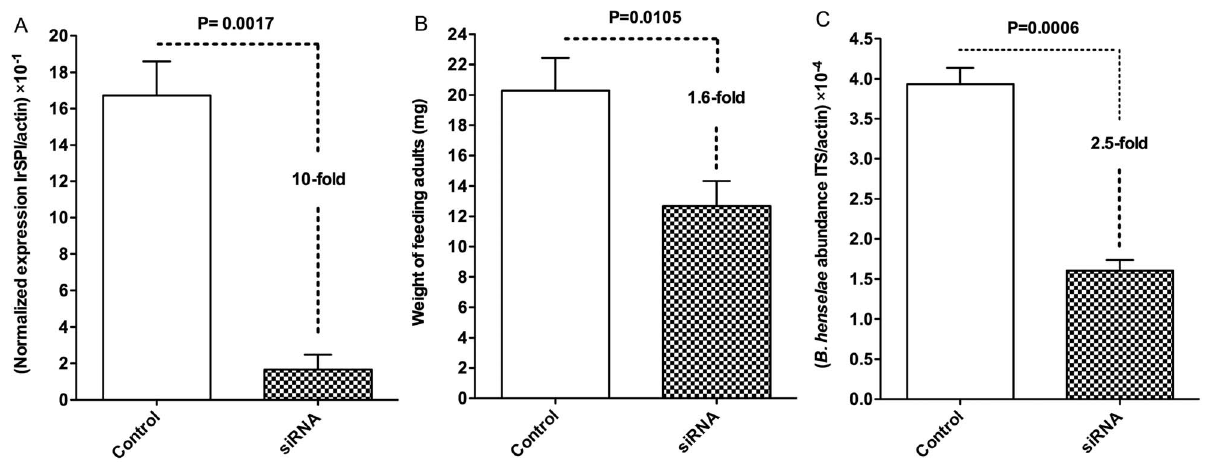
Figure 5. Influence of IrSPI silencing on tick feeding and tick SG infection by B.henselae . IrSPI -siRNA (siRNA) or nuclease free water (control) were microinjected into the body of B. henselae -infected I. ricinus females before ticks were fed a non-infected blood meal during 7 days. A) Quantitative RT-PCR analysis of IrSPI gene expression levels in pools of eight tick SGs from IrSPI -siRNA injected ticks and controls. The results are represented as the mean 6 SEM of qRT-PCR performed in triplicate. B) Weight evaluation of IrSPI -siRNA injected tick body mass compared to controls. The results are represented as the mean 6 SEM of eight ticks weighed individually. C) Quantitative PCR analysis of bacterial load in pools of eight tick SGs from IrSPI -siRNA injected ticks and controls. The results are represented as the mean 6 SEM of qPCR performed in triplicate.